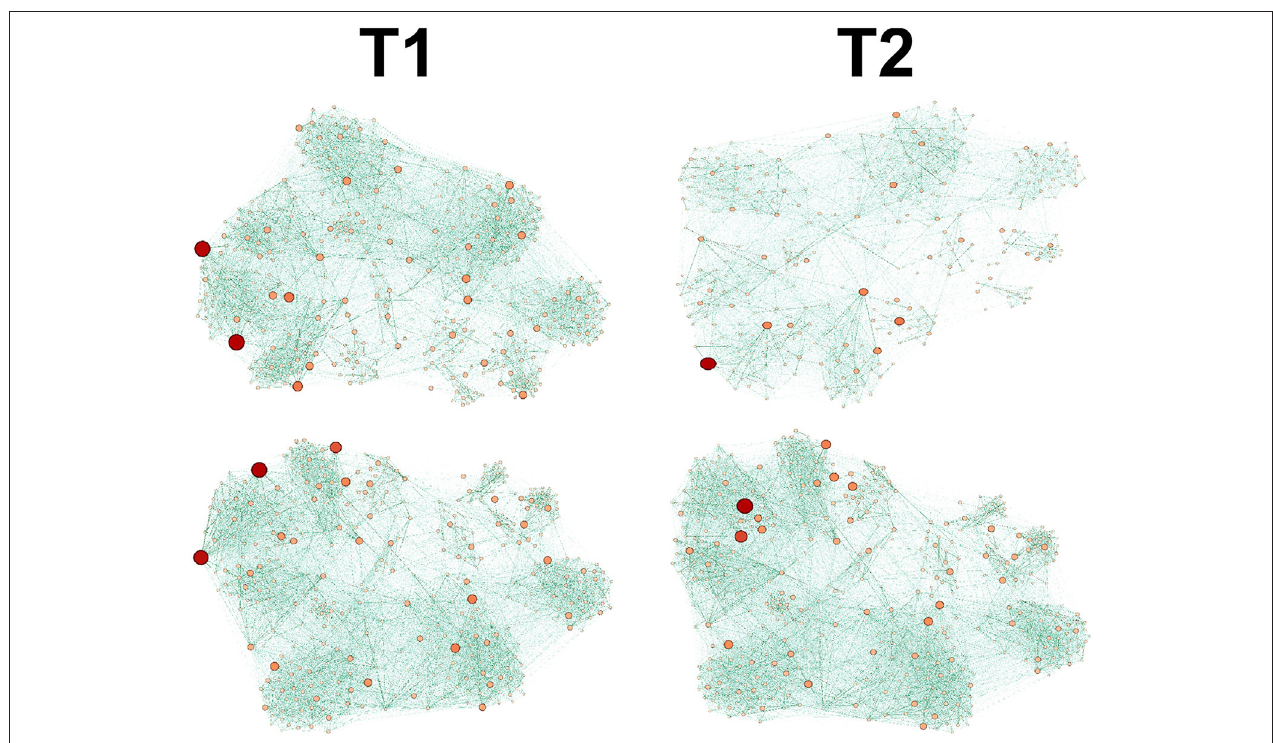
FIGURE 4 | Graph dynamics of Control (up) and Transgenic samples (down), depicted at 2 time points, T 1 < T 2 . The Transgenic graph remains dense, whereas the Control becomes branched and diluted at later time.